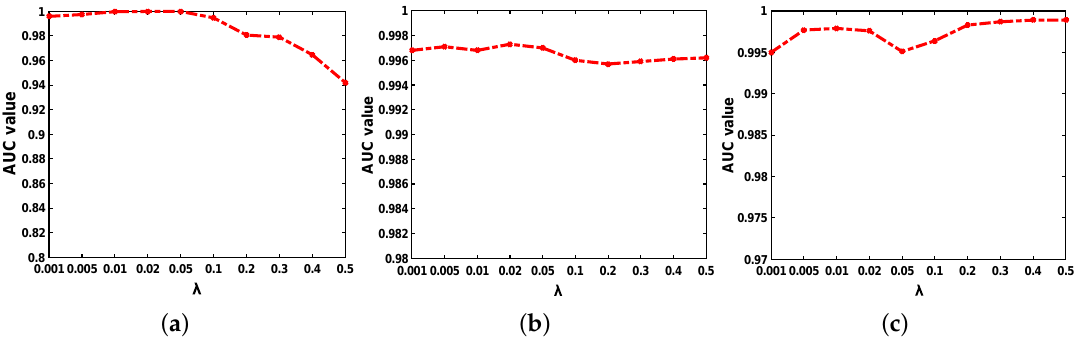
Figure 22. ROC curves achieved by DCLaAW with different λ for each dataset. ( a ) Synthetic dataset; ( b ) San Diego dataset; ( c ) Urban dataset.